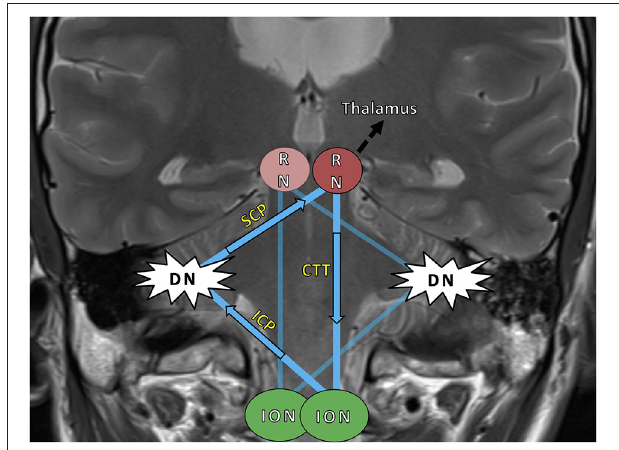
FIGURE 1 | The Guillain–Mollaret triangle (GMT) (blue) and its unidirectional course of inhibitory fibers, which ascend from the dentate nucleus (DN) to the contralateral red nucleus (RN) and then descend ipsilaterally to the inferior olivary nucleus (ION). The bilateral overlapping Guillain–Mollaret triangles together form a “tilted star of David configuration” (5). Fibers of the GMT, which is also called the dentato–rubro–olivary-pathway, overlap with dentato–thalamo–cortical pathways proceeding into both hemispheres (black arrow) ( 10). HOD, hypertrophic olivary degeneration; SCP, superior cerebellar peduncle; ICP, inferior cerebellar peduncle; RN, red nucleus; CTT, central tegmental tract; DN, dentate nucleus; ION, inferior olivary nucleus.